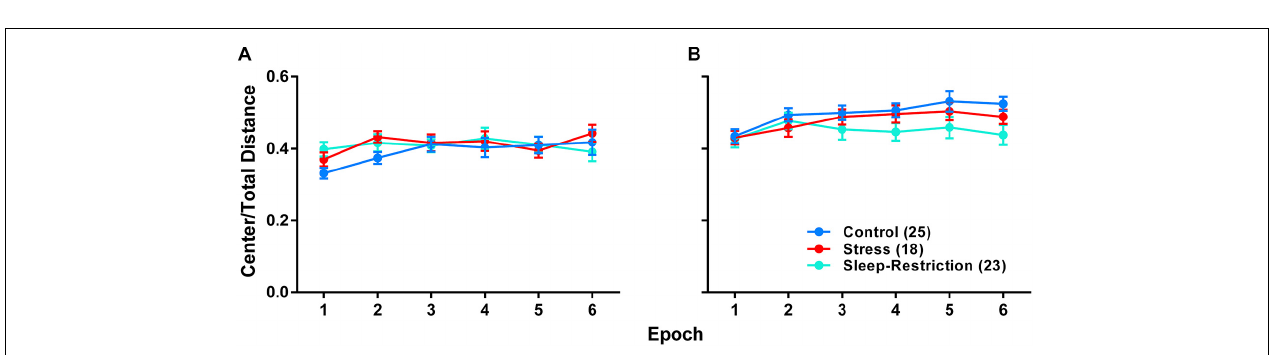
FIGURE 4 | Sleep-restriction resulted in hypoactivity both pre- (P42) (A) and post-recovery (P84). (B) The main effect of condition was statistically significant ( p < 0.001), indicating that, regardless of epoch or age, sleep-restriction resulted in decreased activity levels compared to control and stress groups. Each point represents the mean ± SEM for the number of mice indicated in parentheses.